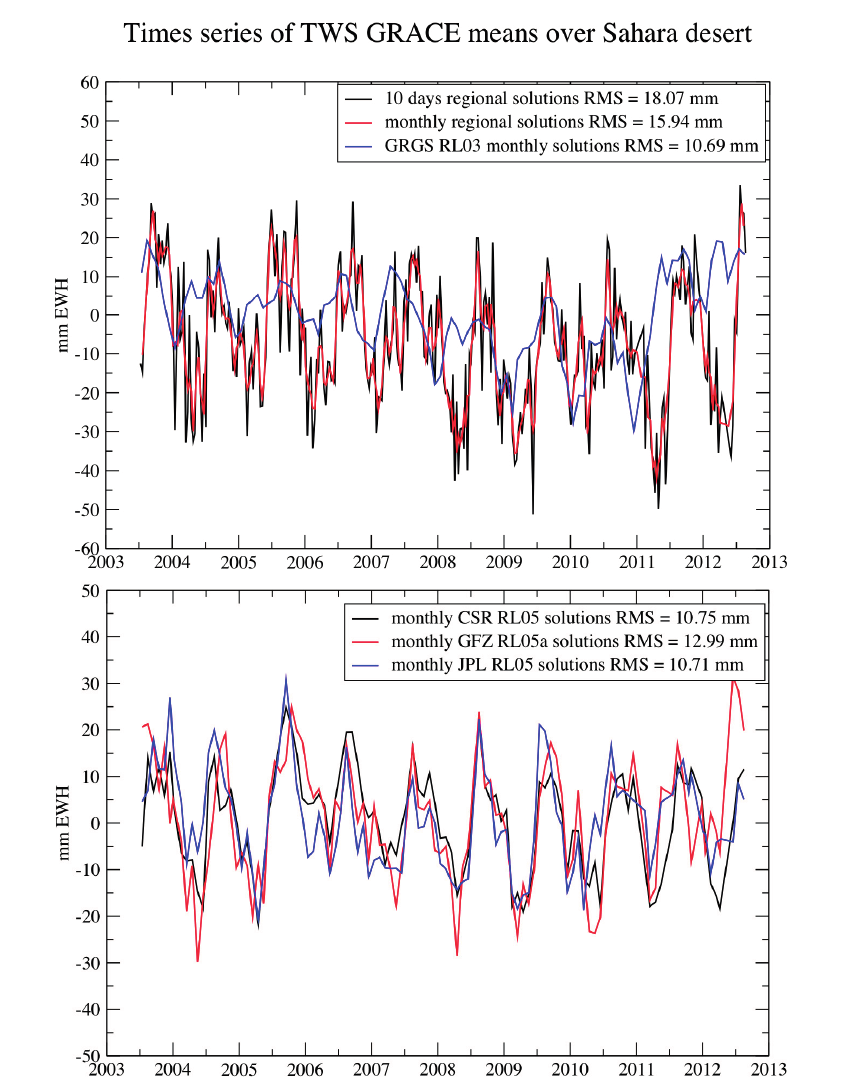
Figure 4. Total water storage (TWS) time series for the dry region of South Algeria (8 in Figure 1) considering the regional GRACE solutions ( top ) and global solutions from different pre-processing centers ( bottom ). Amplitudes over this region are typically less than 20 mm of equivalent water height (EWH) RMS. RL,